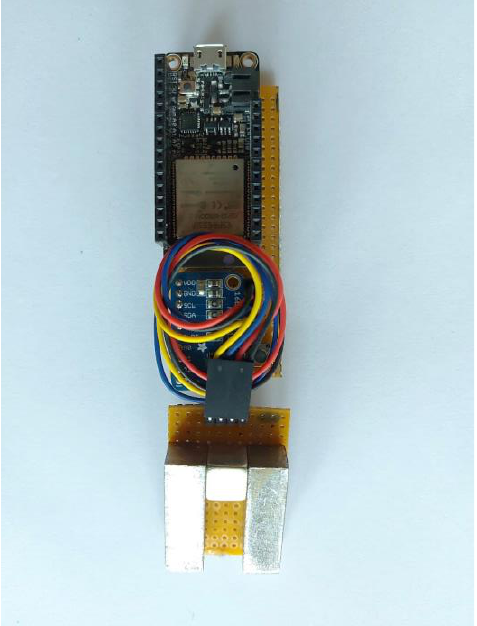
Figure 12. Complete arrangement, including both the electronics and the sensing yoke.